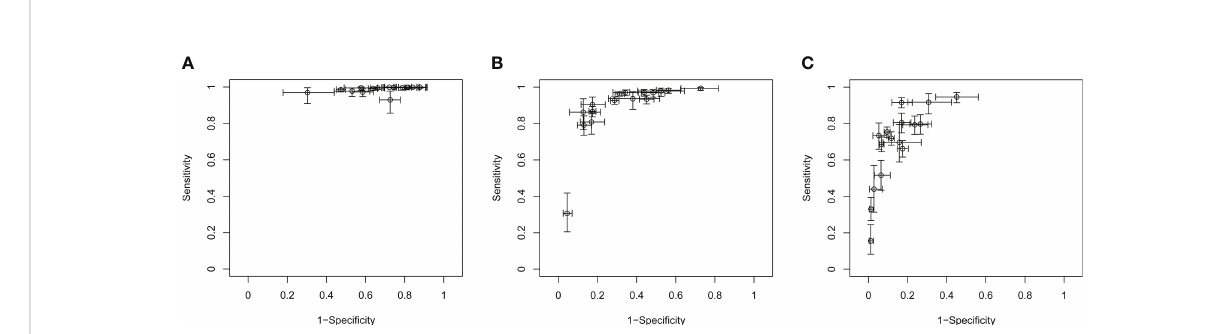
FIGURE 5 Crosshair plots of the sensitivity and speci fi city. Crosshair plots showing individual sensitivity and speci fi city of C-TIRADS 4A (A) , 4B (B) , and 4C (C) in the assessment of thyroid nodules. The estimated accuracy for each study is plotted as a circle, and 95% CI is plotted as arrows. C- TIRADS, Chinese thyroid imaging reporting and data